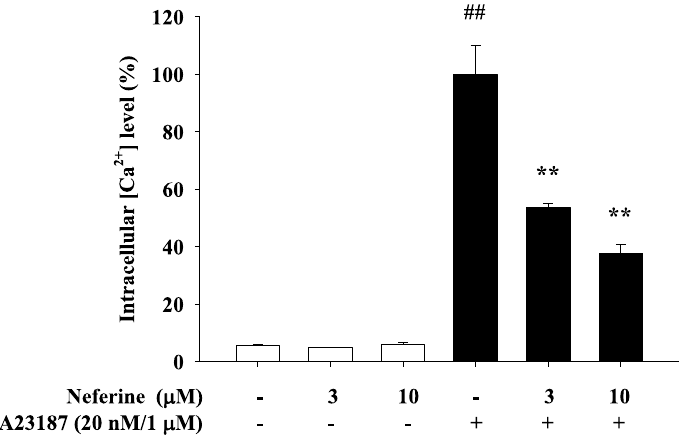
Figure 3. Neferine inhibits the effect of PMA/A23187 in rat mast cells (RBL-2H3) on the level of intracellular calcium. The [Ca 2+ ]i elevation induced by PMA/A23187 in rat mast cells (RBL-2H3) was affected by neferine 3 μ M and 10 μ M for 20 min. Values represent the mean ± SEM from at least three experiments. ## p < 0.01 vs. control, ** p < 0.01 vs. negative control, PMA/A23187.